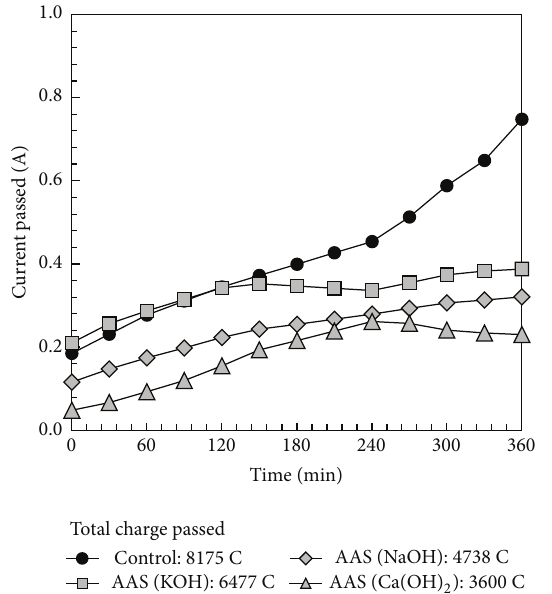
Figure 5: Charged current with time depending on activator type.